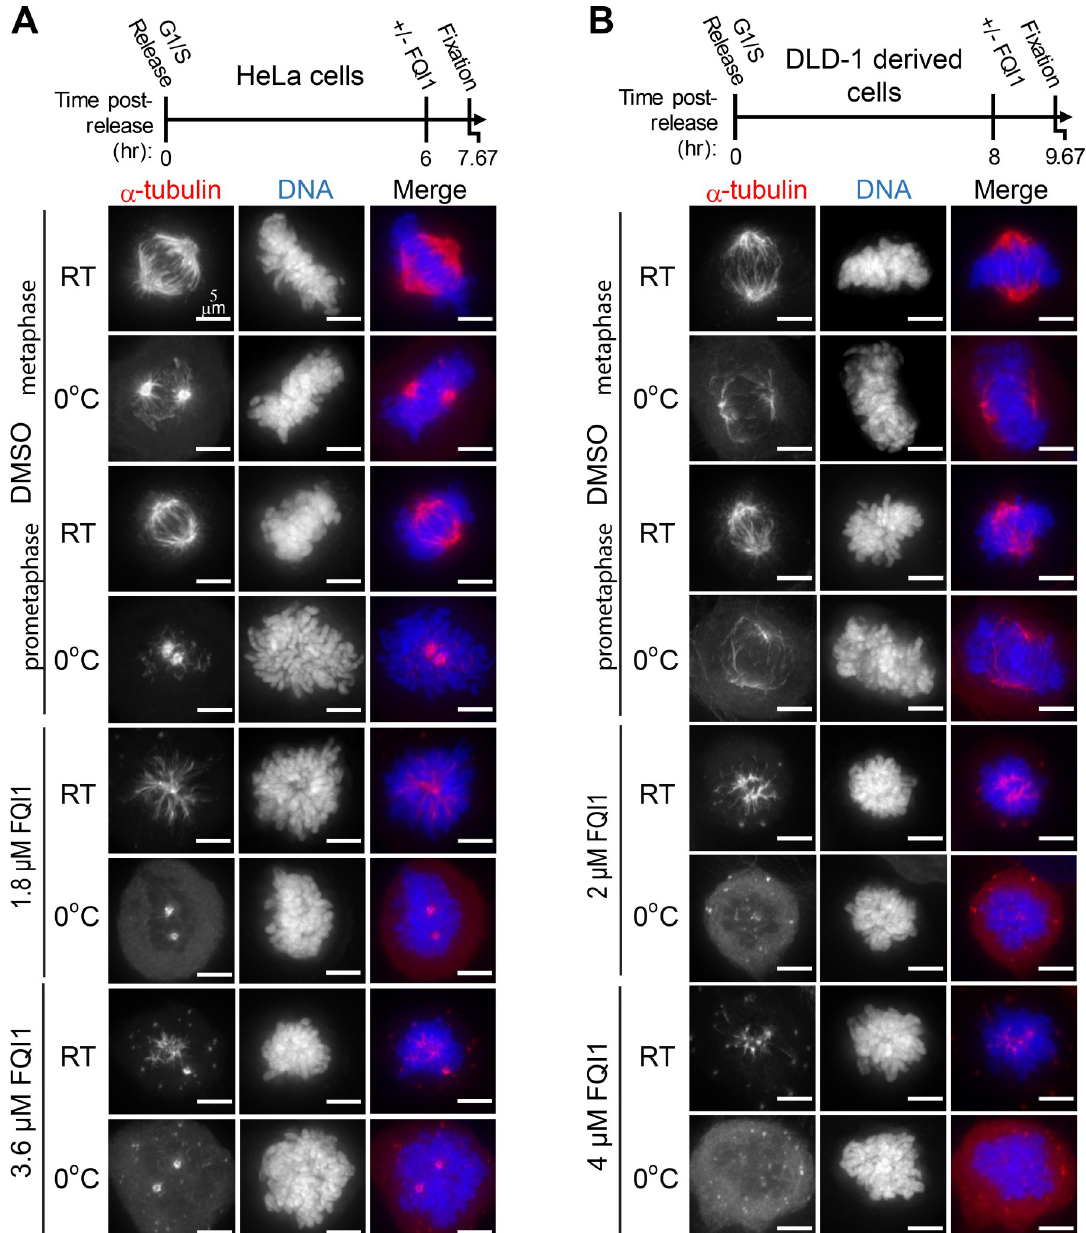
Fig 3. FQI1 induces spindle defects in a concentration-dependent manner and reduces stable MT-kinetochore attachments. (A) Top: Schematic of treatments of HeLa cells following release from a double thymidine block. Just prior to mitotic entry, cells were incubated with vehicle (DMSO), 1.8 μ M FQI1, or 3.6 μ M FQI1 for 100 minutes, and then fixed at ambient temperature (RT) or after ice water incubation (0˚C). Images are representative from 3 independent biological experiments, with images totaling 21–27 cells per condition. Scale bars are 5 μ m. (B) Top: Schematic for treatments of DLD-1 derived cells following release from a double thymidine block. Treatments just prior to mitotic entry included vehicle (DMSO), 2 μ M FQI1, or 4 μ M FQI1. Cells were analyzed as described in (A). Images are representative from 2–3 independent biological experiments, with images totaling 16–24 cells per